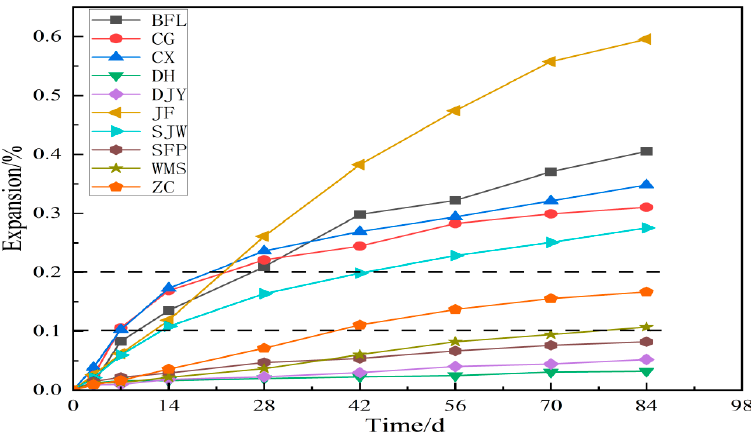
Figure 4. The expansion of the mortar bars prepared according to RILEM AAR-2.